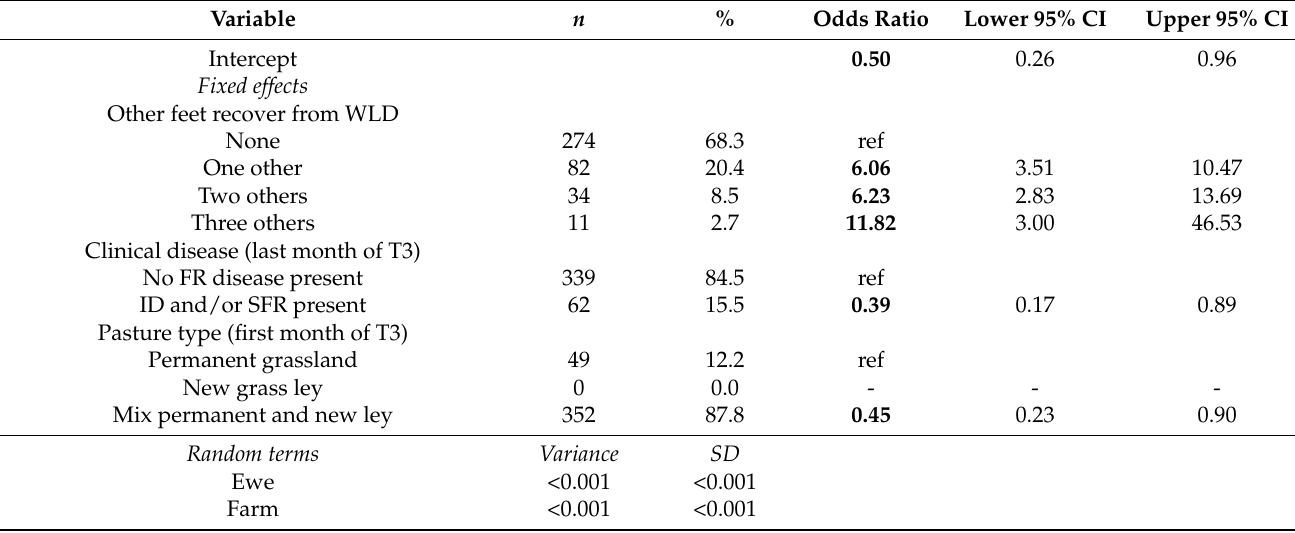
Table 16. Final multivariable model of the associations with the recovery from WLD at foot-level for 401 observations of 200